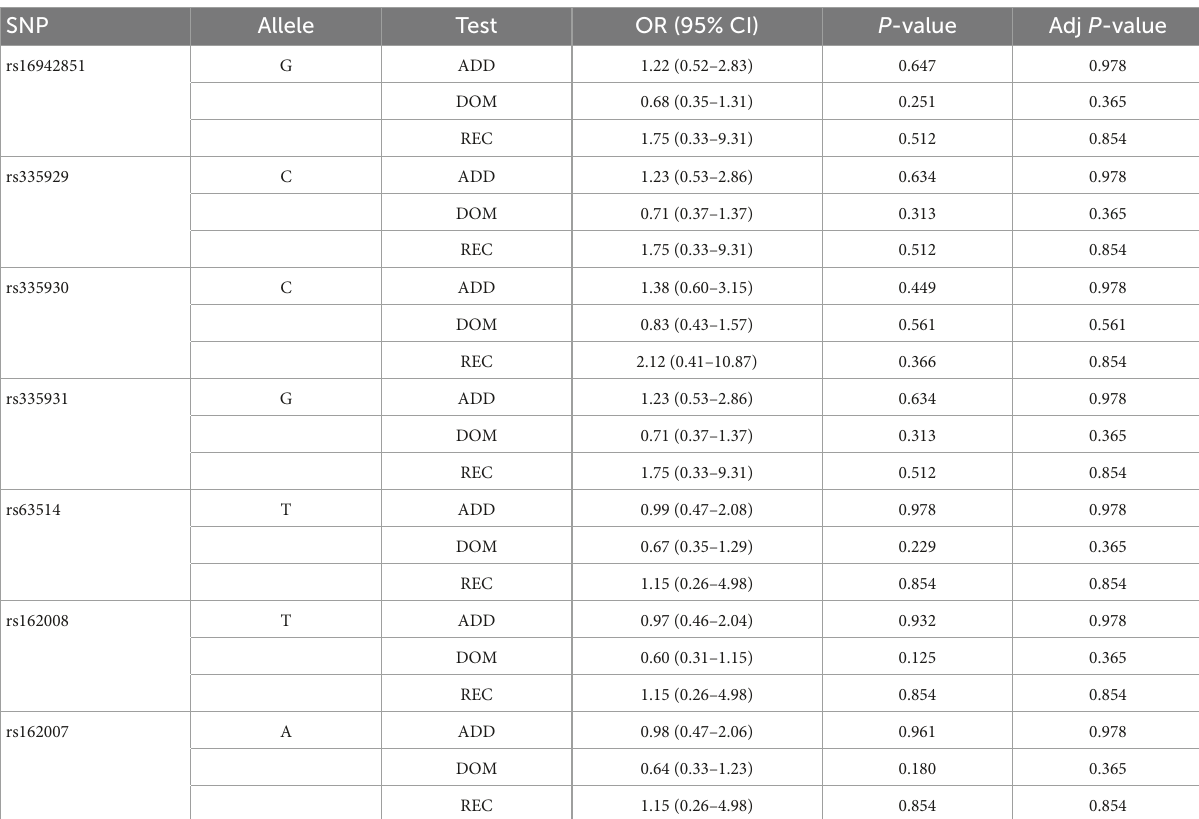
TABLE 4 Genotype association using different genetic models. SNP Allele